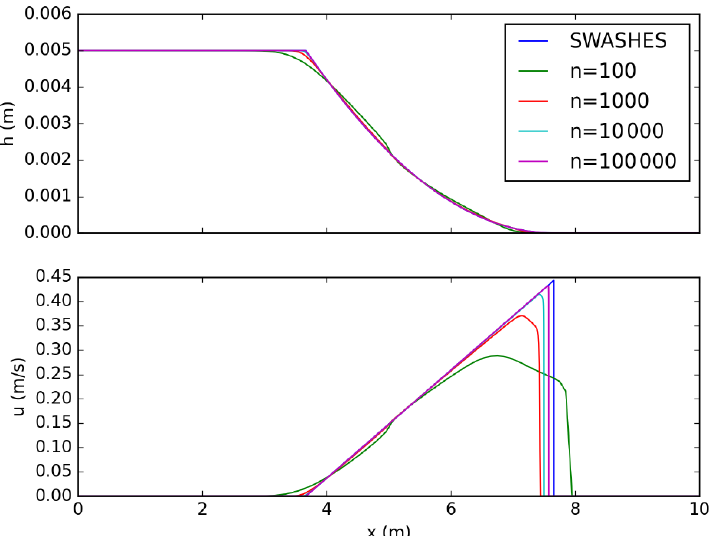
Figure 6. Dam break on dry bed without friction: model predictions for different number of grid cells. SERGHEI-SWE converges to the analytical solution (Ritter’s solution) as the grid is